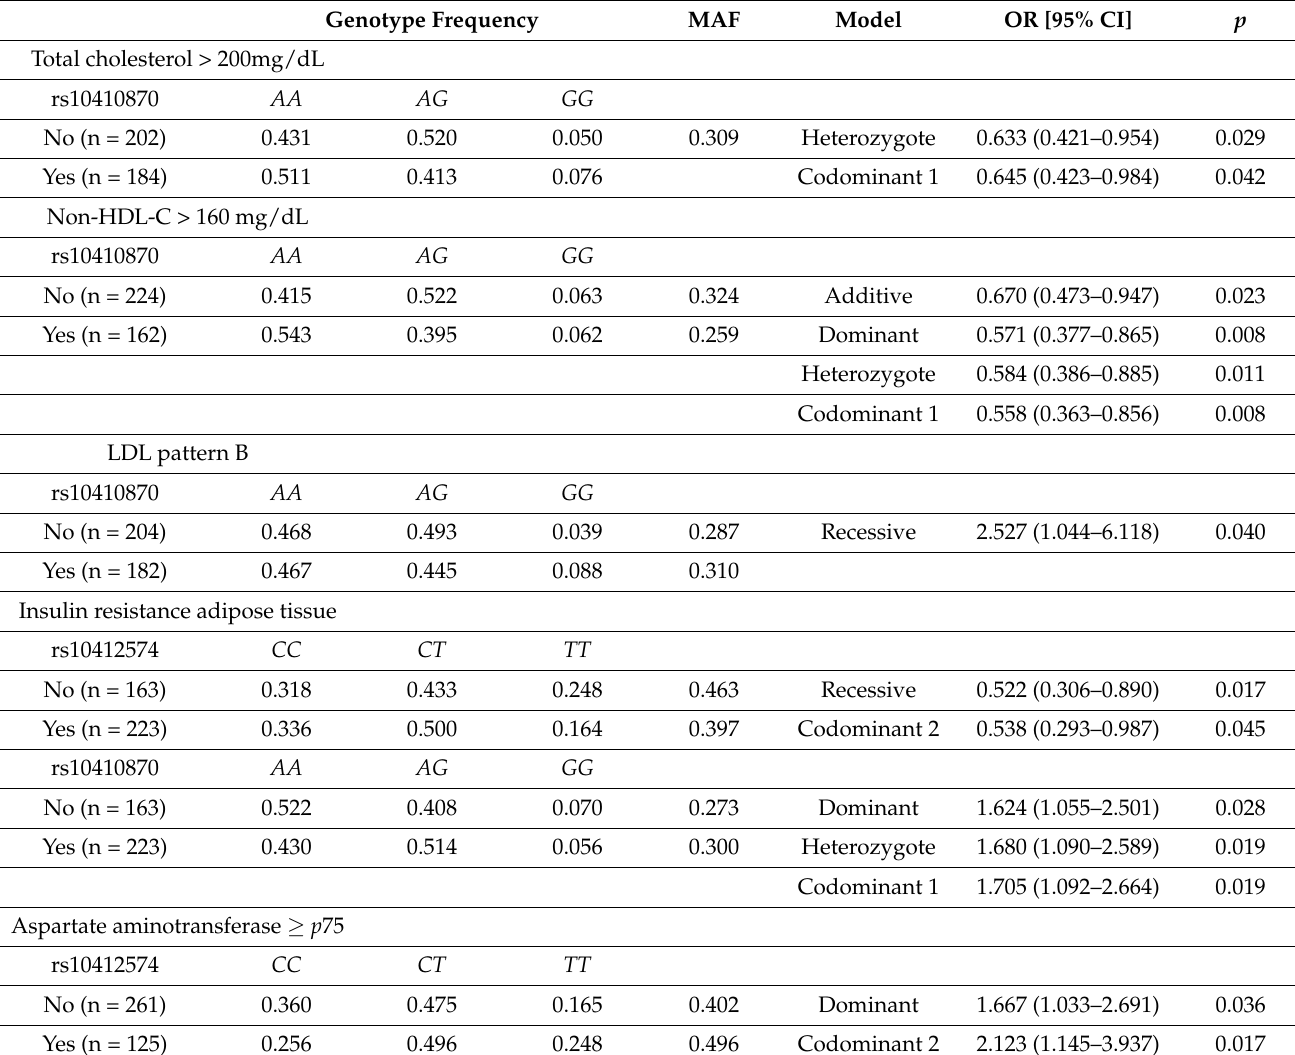
Table 2. Association of FOXA3 polymorphisms with metabolic risk factors in SA subject.